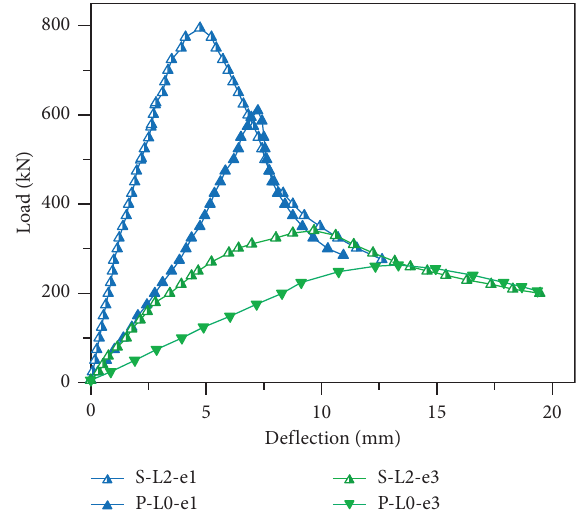
Figure 7: Load-lateral deflection curves of strengthened and unstrengthened columns with different